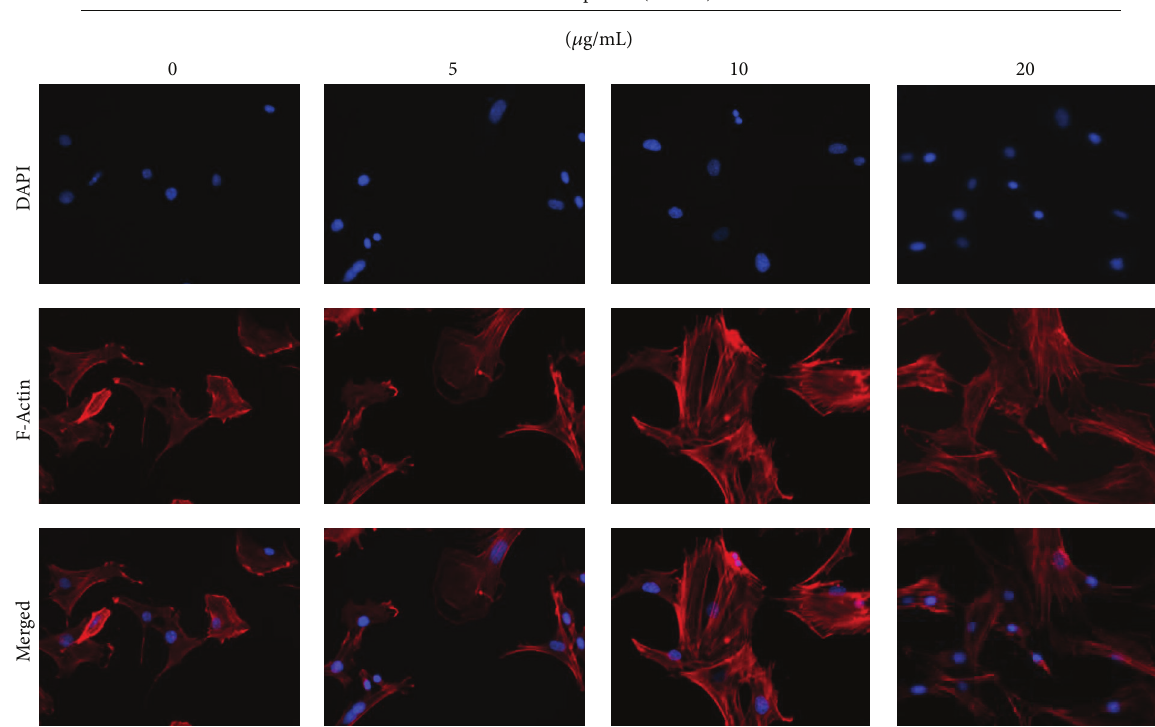
Figure 5: Cytoskeleton (F-actin fibers) organization in bmMSCs after exposure to 0, 5, 10, and 20 𝜇 g/mL ox-LDL for 6 hours.